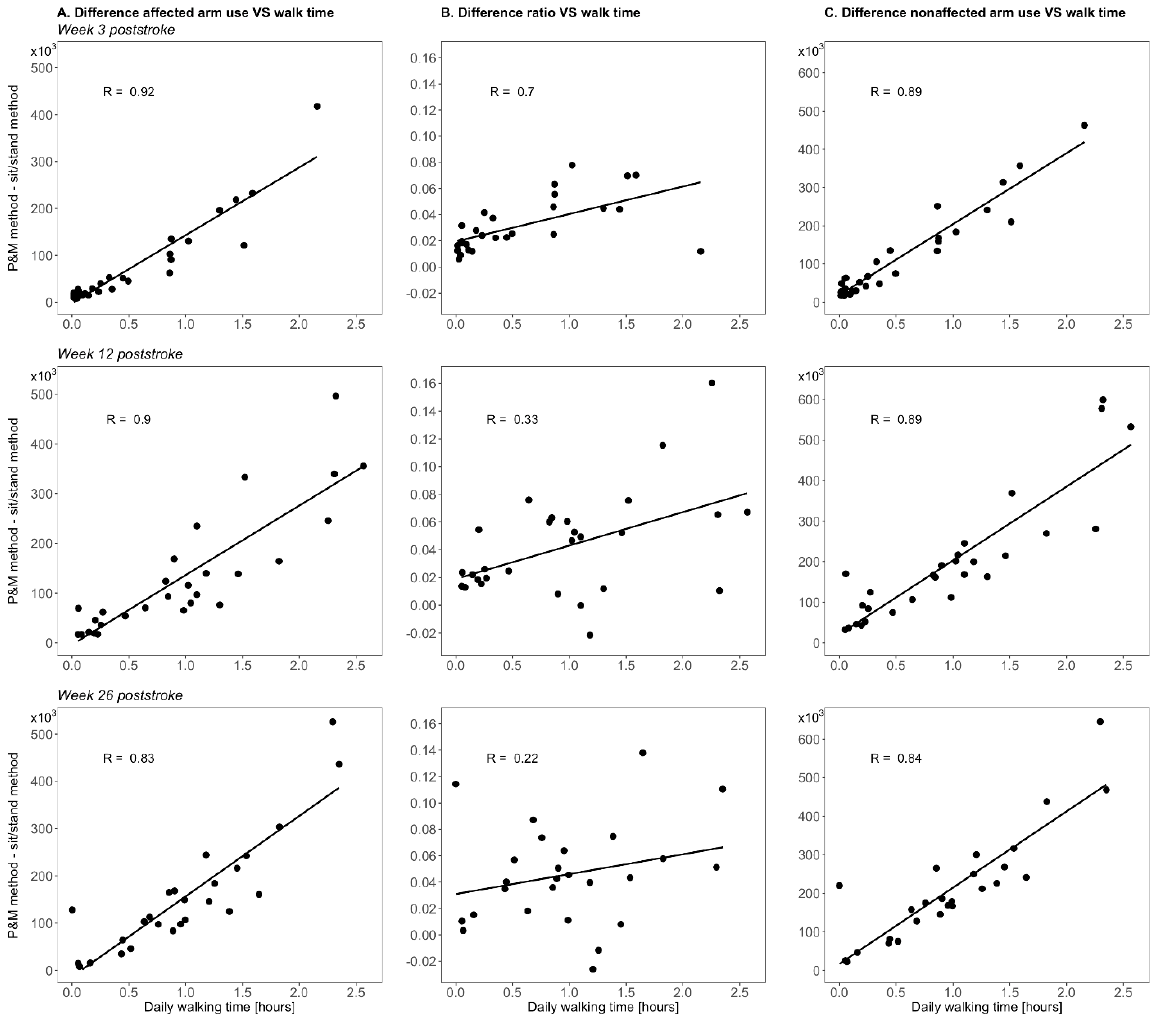
Figure 5. Scatterplots showing the daily walking time versus the difference in arm use outcome between the P&M method and the sit/stand method. Scatterplots are shown for week 3 poststroke (upper row), week 12 poststroke (middle row), and week 26 poststroke.